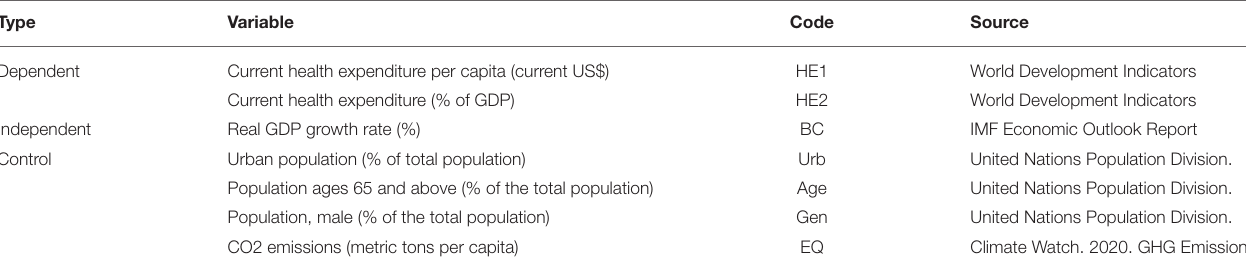
TABLE 2 | Description of variables.